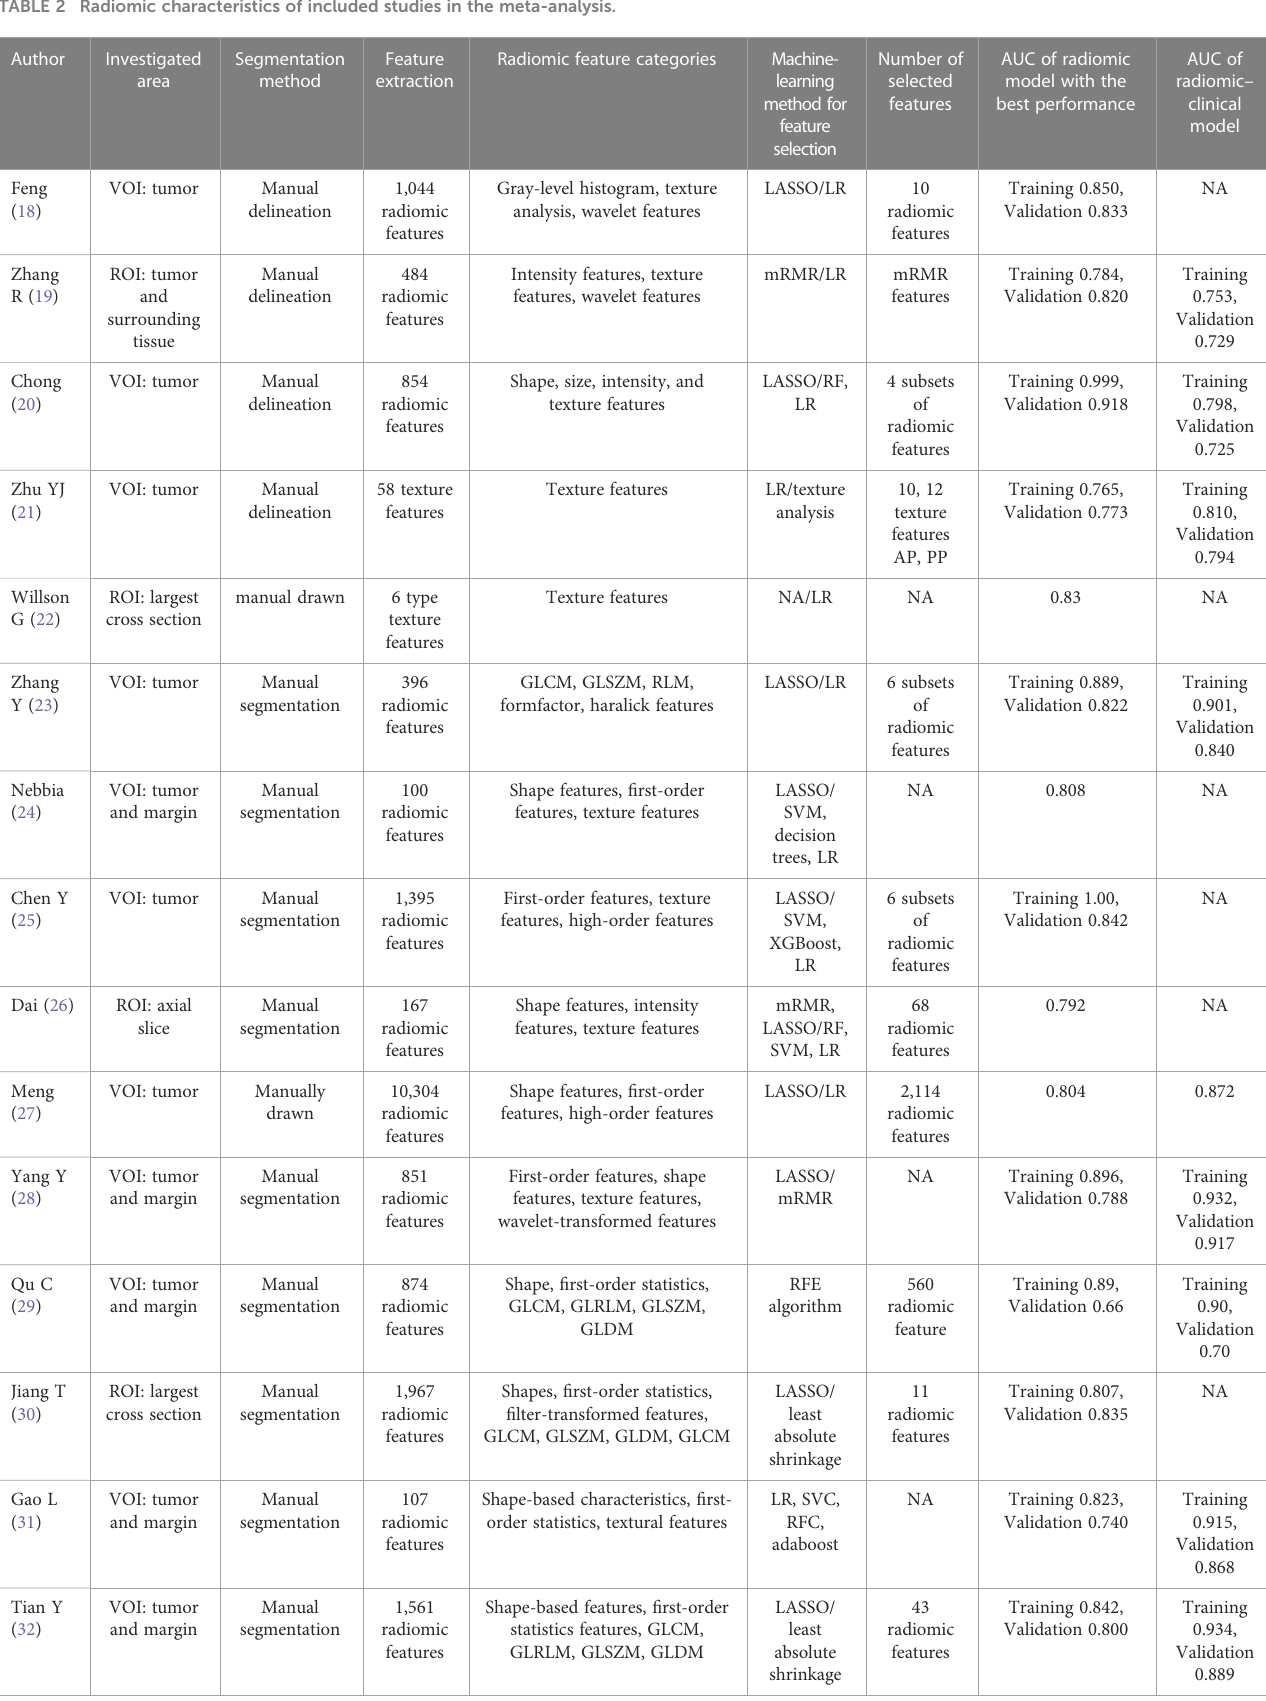
TABLE 2 Radiomic characteristics of included studies in the